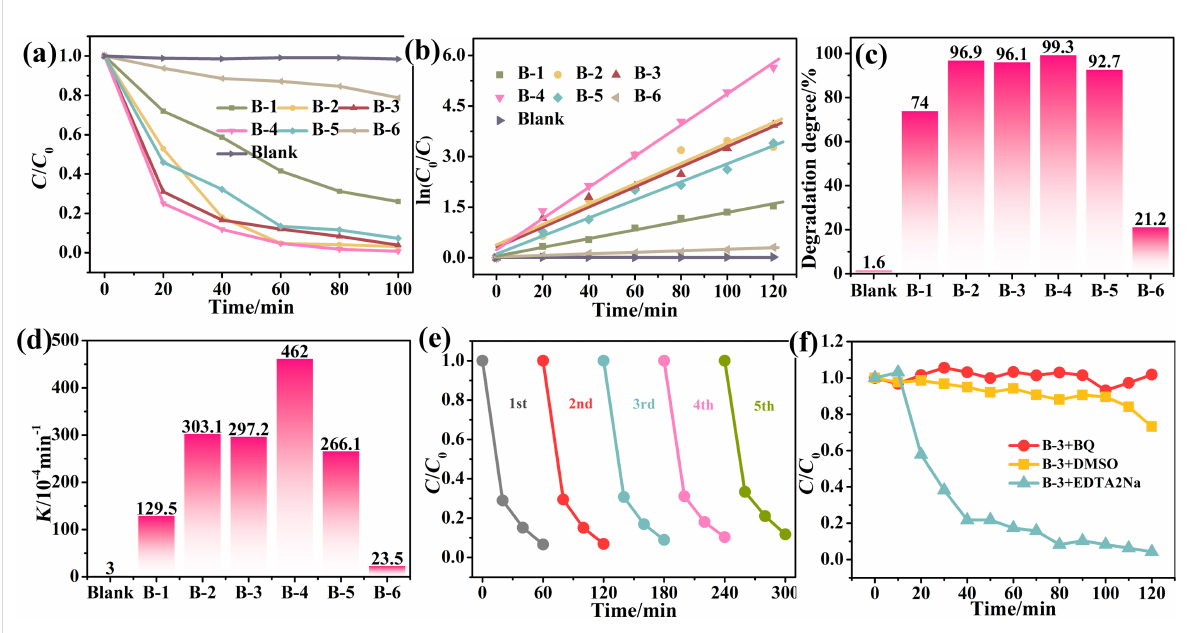
Figure 6: Photocatalytic activity under visible light illumination. (a) The rhodamine B (RhB) solution degradation of the as-prepared samples with sam- ple with no catalyst and P25 as comparison. (b) The linear fitting of the pseudo-first kinetic model. (c) Photodegradation degree within 100 min of the as-synthesized sample. (d) Photocatalytic rate of all the samples. (e) Recycling tests for the B-4 sample whose Bi/Zn molar ratio is 13. (f) The effect of sacrificial agents on the RhB photodegradation of the B-3 sample (Bi/Zn